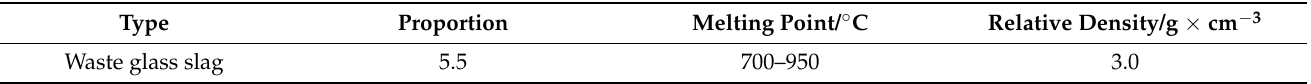
Table 3. Physical properties of waste glass slag.